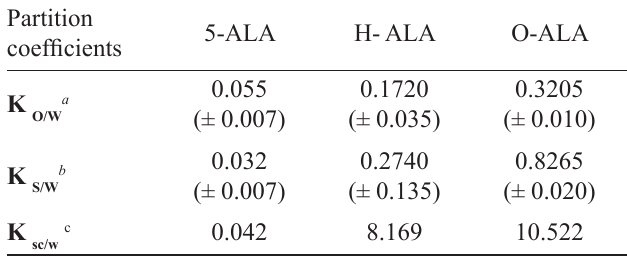
TABLE II - Octanol/water (K coefficients (K) of 5-ALA and its n-alkyl